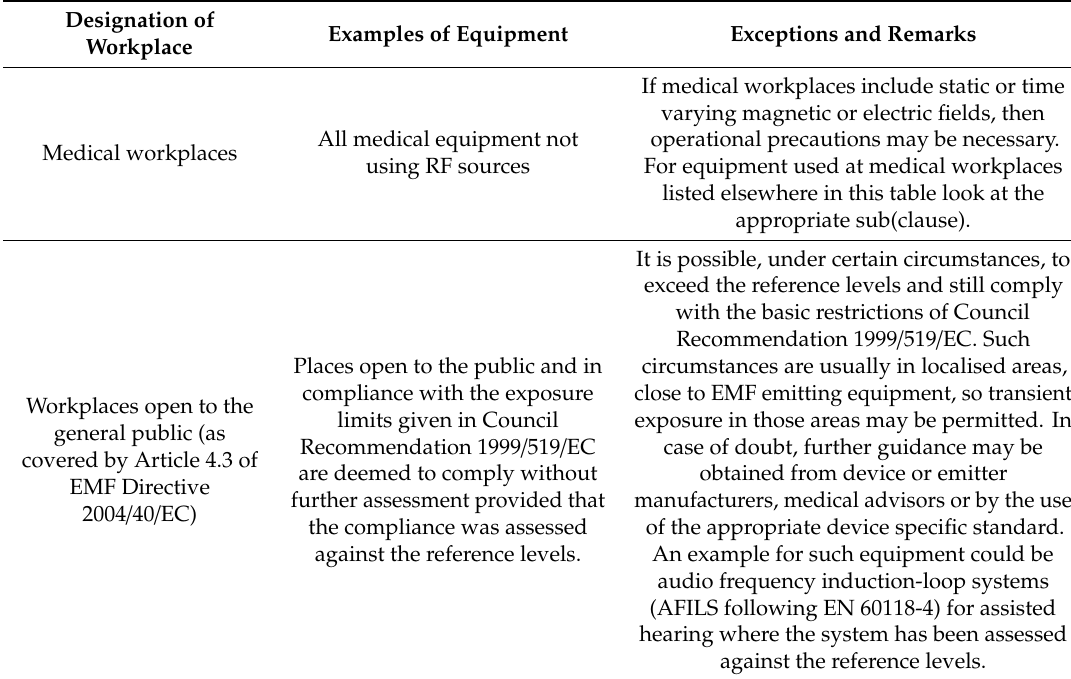
Table 1. Example from Table A.1—compliant workplaces and equipment with exceptions (“whitelist”) of the